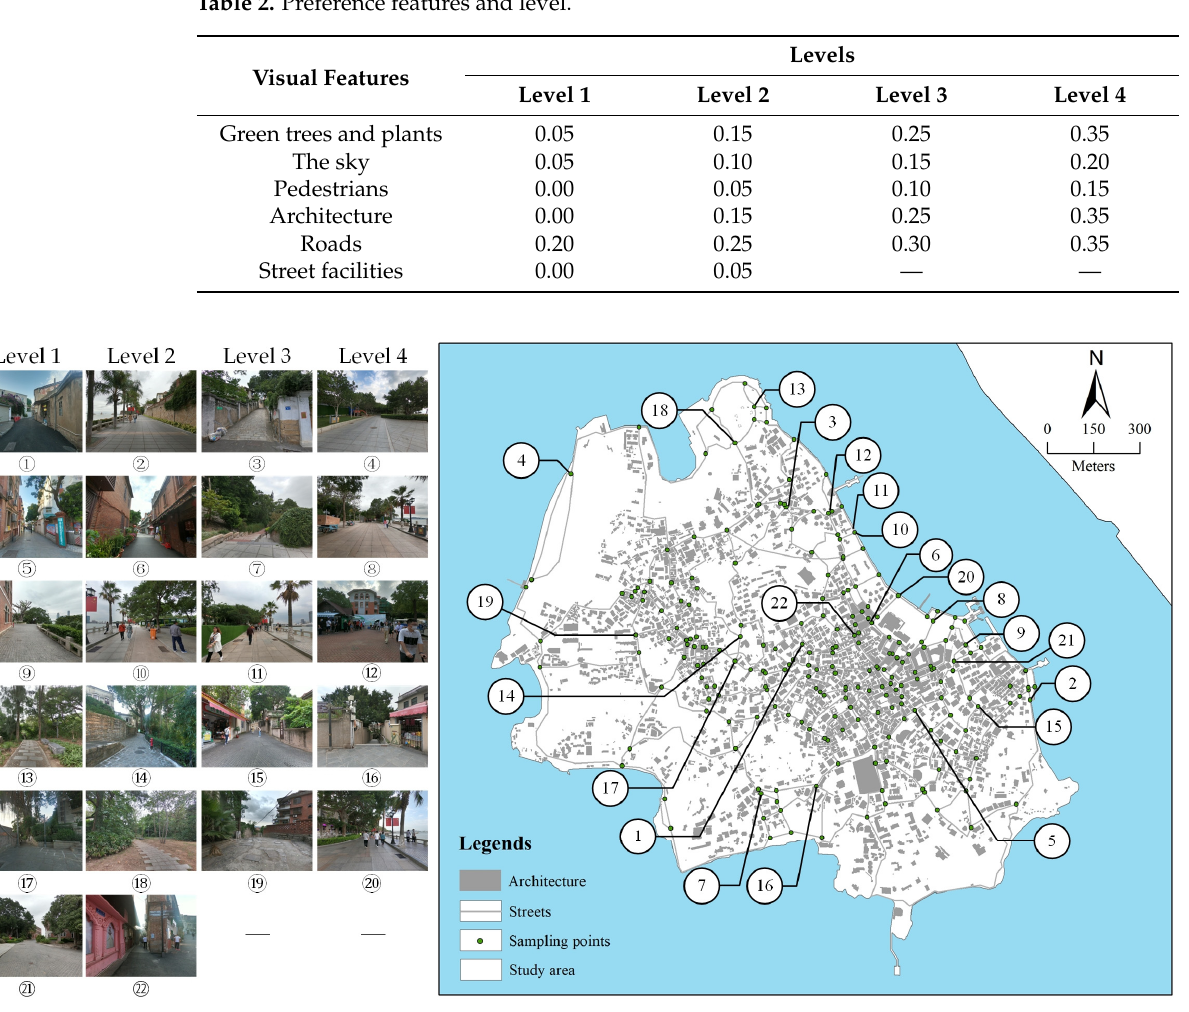
Figure 3. Example s of each level of the visual features. Figure 3. Examples of each level of the visual